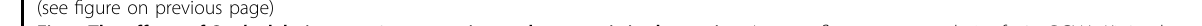
Fig. 5 The effects of Sgpl1 deletion on p21 expression and apoptosis in the testis. a Immuno fl uorescence analysis of p21, PCNA, Ki-67, cleaved caspase-3, and TUNEL (green) in WT and KO testes from 14- and 21-day-old mice. ( n = 3 independent experiments). The nuclei were counterstained by DAPI (blue). The small white boxes indicate the location of the enlarged areas, as shown in the following images. The cells in the dashed line box are Leydig cells. Scale bars: 100 μ m. Asterisks (*) indicate the seminiferous tubules with few PCNA-positive signals. b The percentage of seminiferous tubules with p21-, PCNA-, Ki-67-, cleaved caspase-3- and TUNEL-positive signals in WT and KO testes from 14- and 21-day-old mice. ( n = 3 independent experiments. The total number of 450 tubules was scored in each group). c The percentage of Leydig cells with p21-, PCNA-, Ki-67-, cleaved caspase-3- and TUNEL-positive signals in WT and KO testes from 14- and 21-day-old mice. ( n = 3 independent experiments. The total number of 1000 Leydig cells was scored in each group). The mRNA ( d ) and protein ( e , f ) levels of p21 and PCNA in testes from 21-day-old WT and KO mice. ( n = 3 independent experiments). β -actin was used as a loading control. g , h The protein levels of cleaved caspase-3 in testes from 21-day-old WT and KO mice. ( n = 3 independent experiments). GAPDH was used as a loading control. Bars indicate the mean ± SEM. ns no signi fi cance, * p < 0.05, ** p < 0.01 and *** p < 0.001 vs. the WT